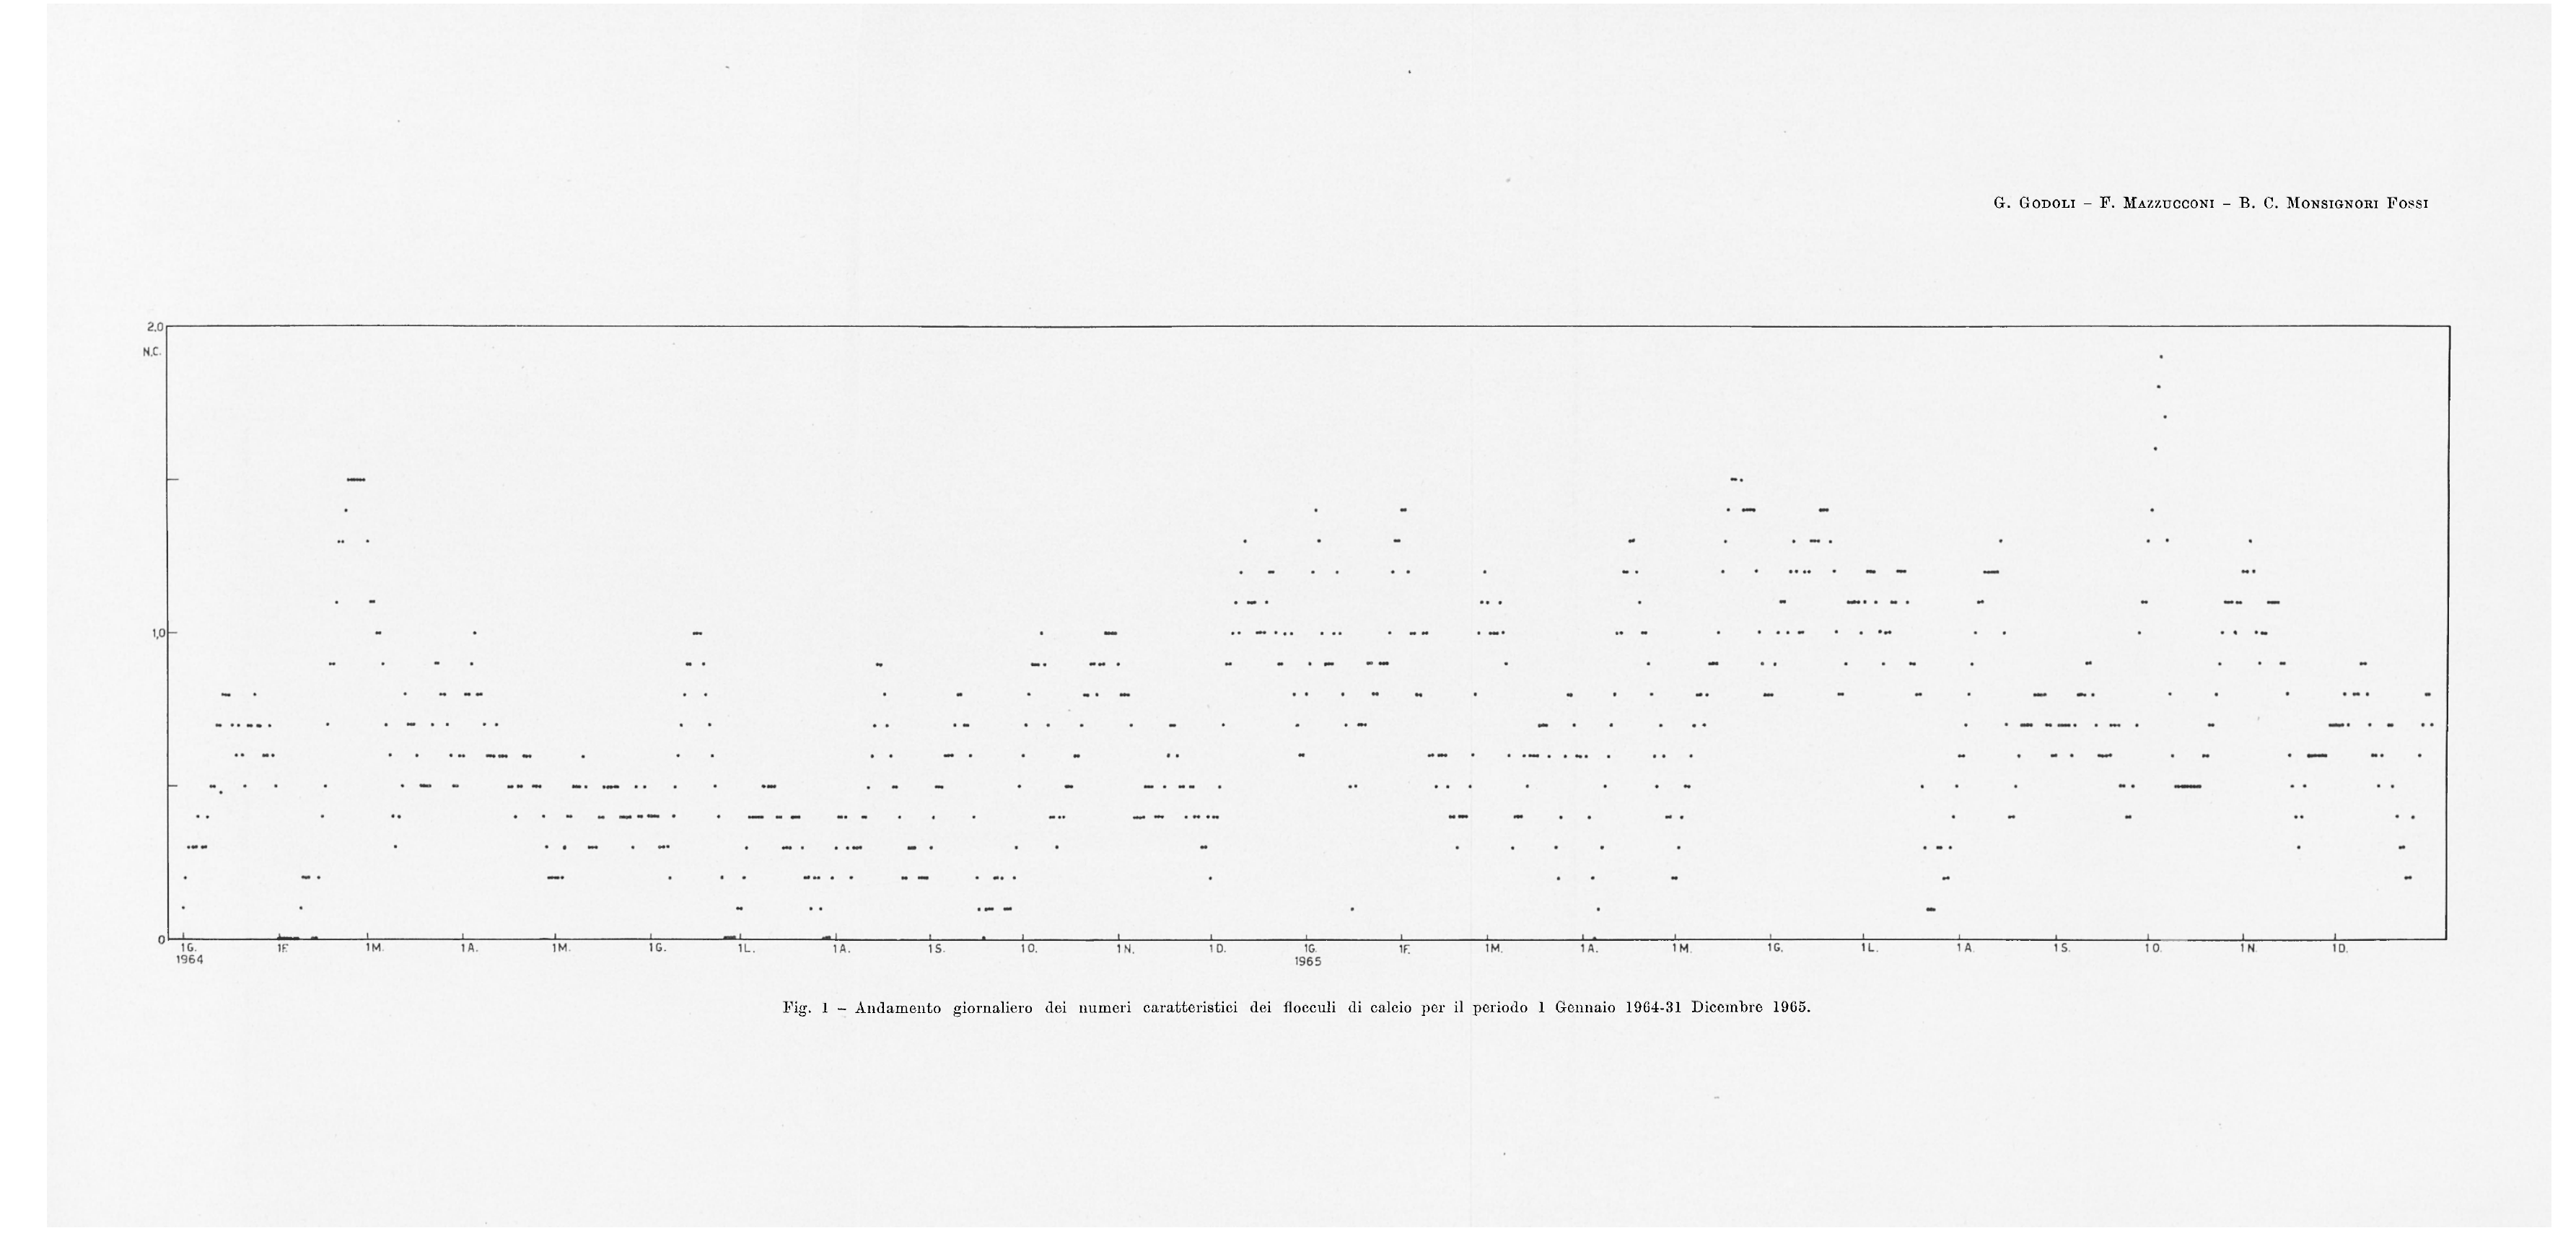
Fig. 1 - Andamento giornaliero dei numeri caratteristici